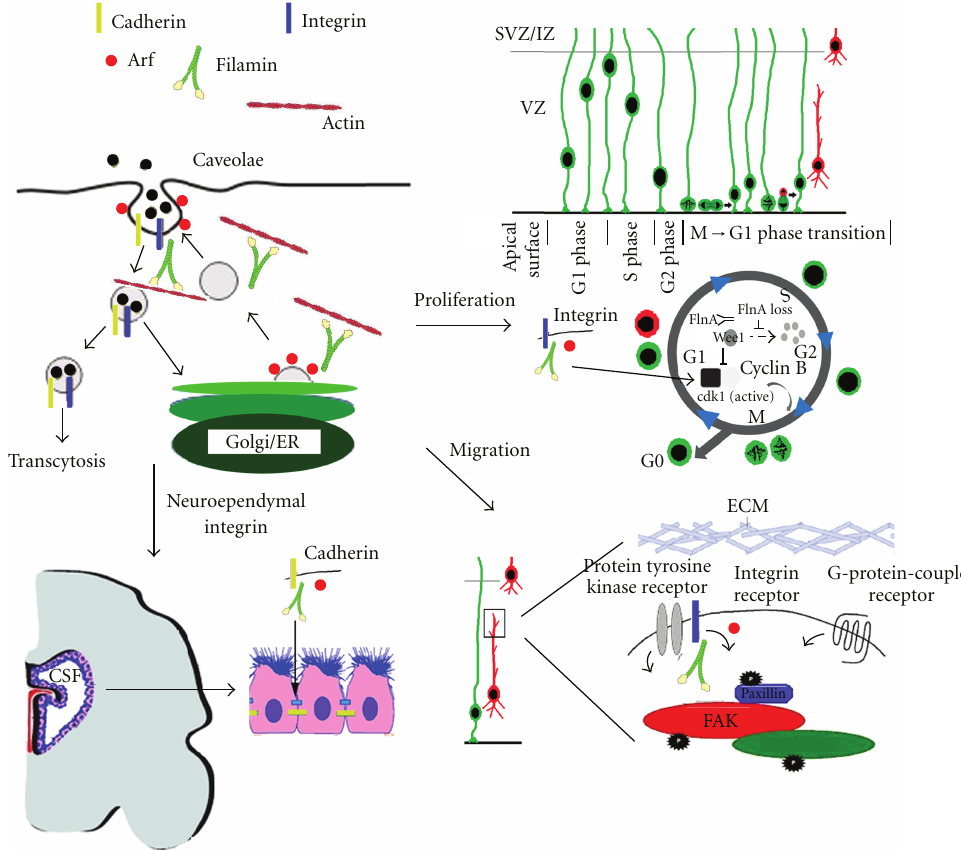
F 1: Periventricular heterotopia as a disorder of vesicle trafficking. �chematic �gure illustrates the disruption of various developmental processes that give rise to features seen in PH. Disruption of �lamin-ARF- (via BIG2) mediated vesicle trafficking can disrupt both caveolin- mediated endocytosis and presumably trafficking from the Golgi to the membrane. Vesicle trafficking dictates the delivery and degradation of various cell cycle proteins and thereby in�uences cell proliferation. Disruption of the cyclin B proteins leads to microcephaly in PH. Vesicle trafficking also alters the distribution of proteins involved in neuronal migration such as paxillin. Loss of PH impairs neuronal migration and the morphology of migratory neurons. Lastly, the loss of neuroependymal integrity giving rise to heterotopia is due to impairments in the cell adhesion along the ventricular lining. Genes that disrupt vesicle trafficking impair cell-cell adhesion and disrupt the integrity of the